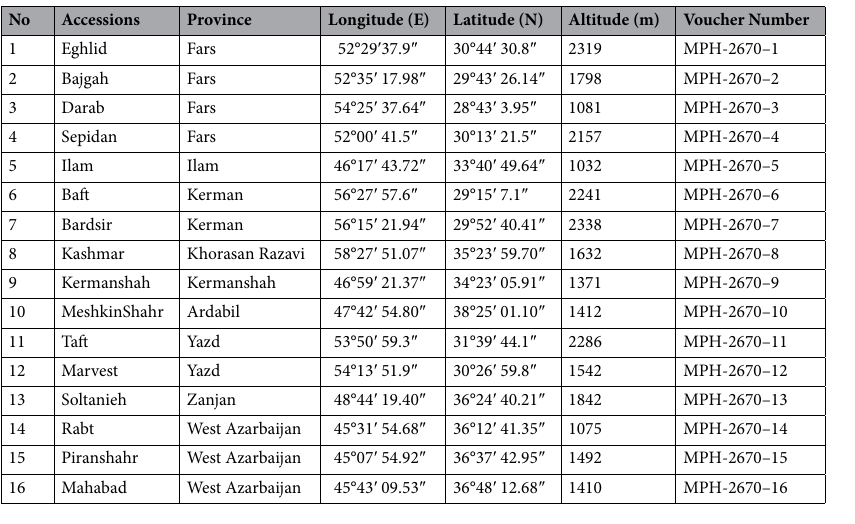
Table 1. Origin, Geographical characteristics of different G. glabra accessions collected from